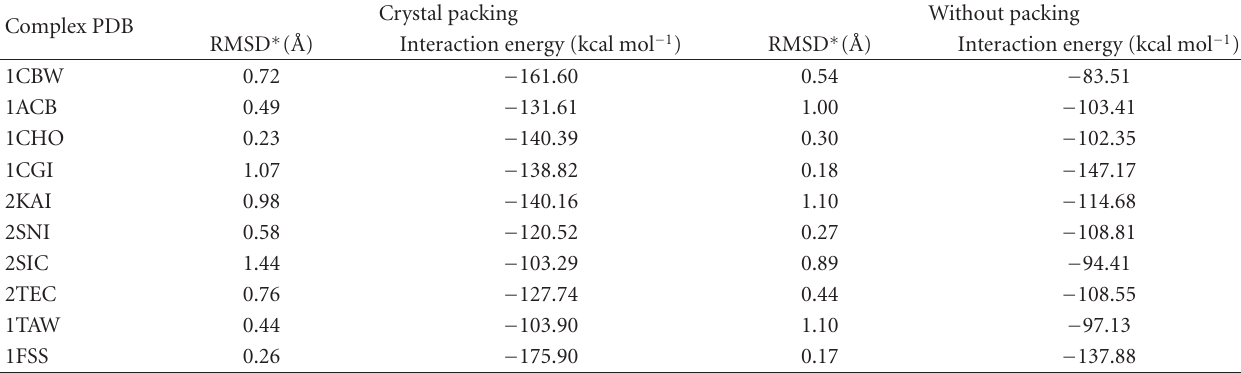
Table 3: Comparison between docking with crystal packing and without crystal